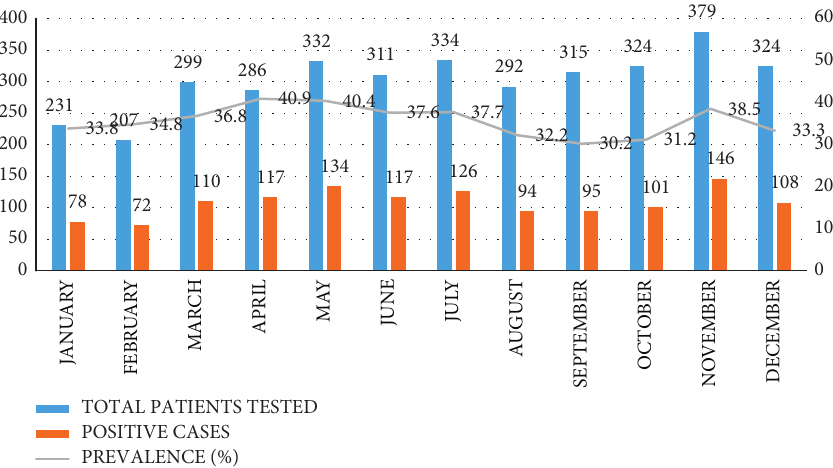
Figure 4: General temporal trends of H . pylori infection at AAR selected clinics.